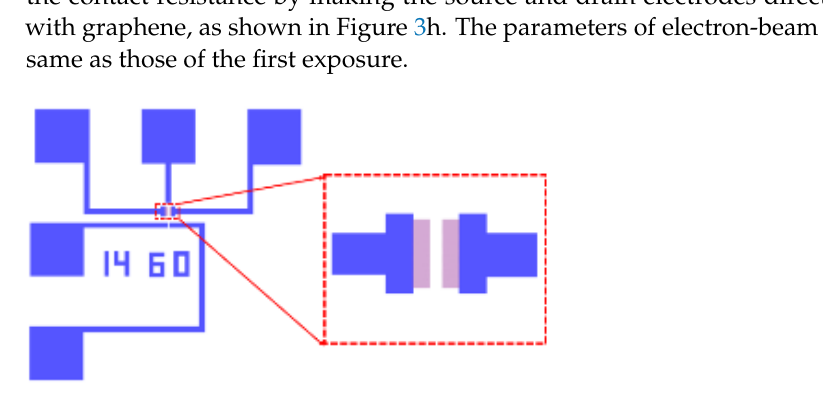
Figure 5. The layout of evaporating metal for the source and drain.